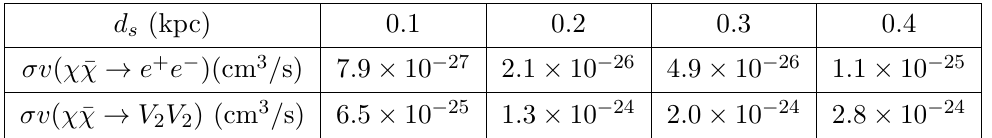
Table 1 . Best-(cid:12)tted cross sections of the (cid:31) (cid:22) (cid:31) ! e + e (cid:0) and (cid:31) (cid:22) (cid:31) ! V 2 V 2 processes for di(cid:11)erent d s values. Here V 2 is the L (cid:22) (cid:0) L (cid:28) gauge boson.